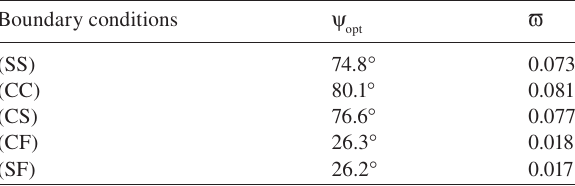
Table 6 Effect of boundary conditions on the optimum results. Boundary conditions ψ